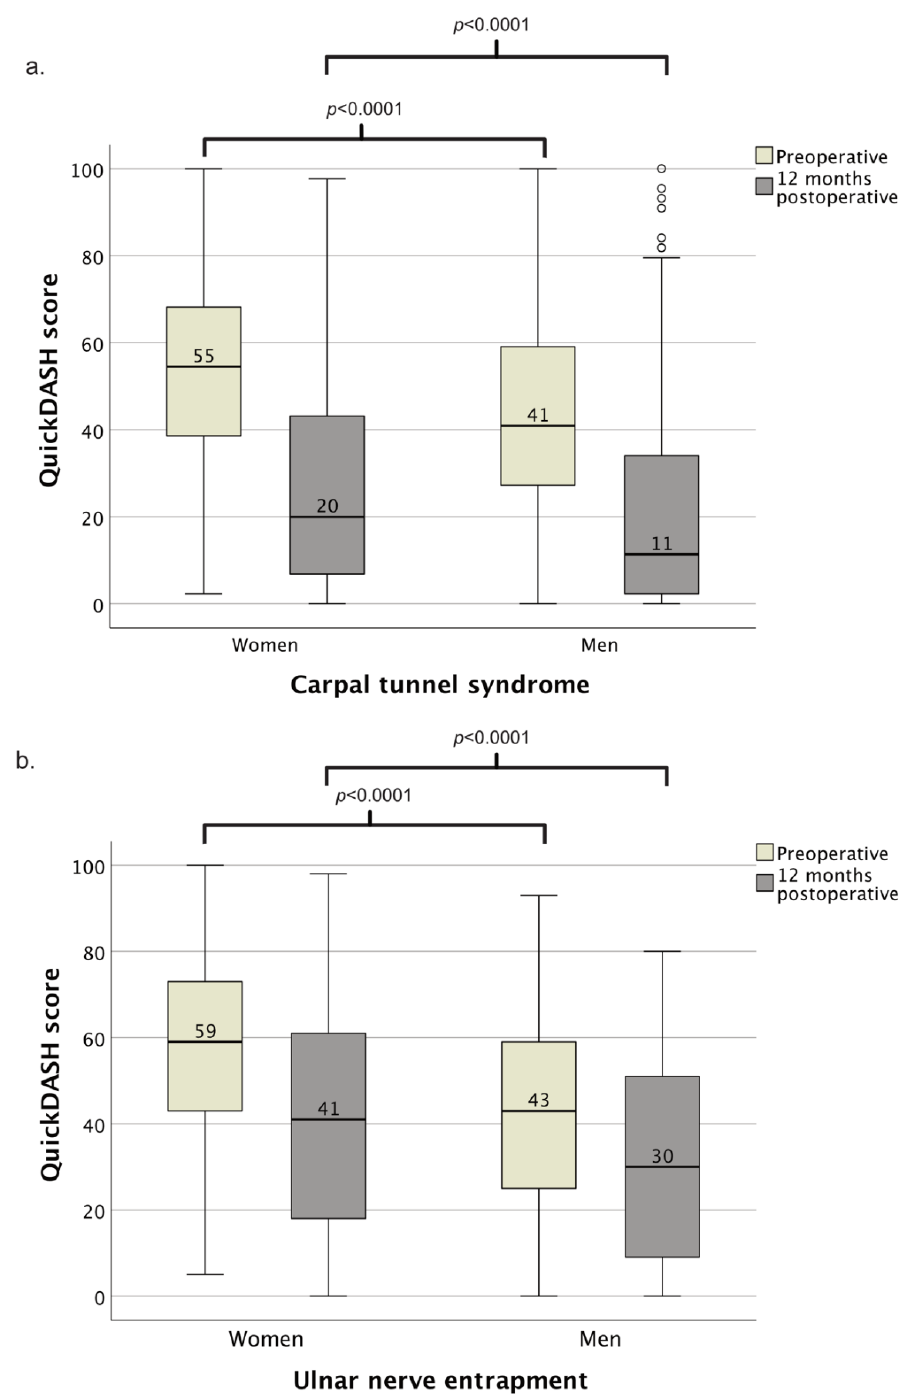
Figure 1. Boxplot of sex differences in QuickDASH scores for patients having surgery for carpal tunnel syndrome ( a ) or ulnar nerve entrapment at the elbow ( b ) preoperative and 12 months postoperative. QuickDASH–Quick Disabilities of Arm, Shoulder and